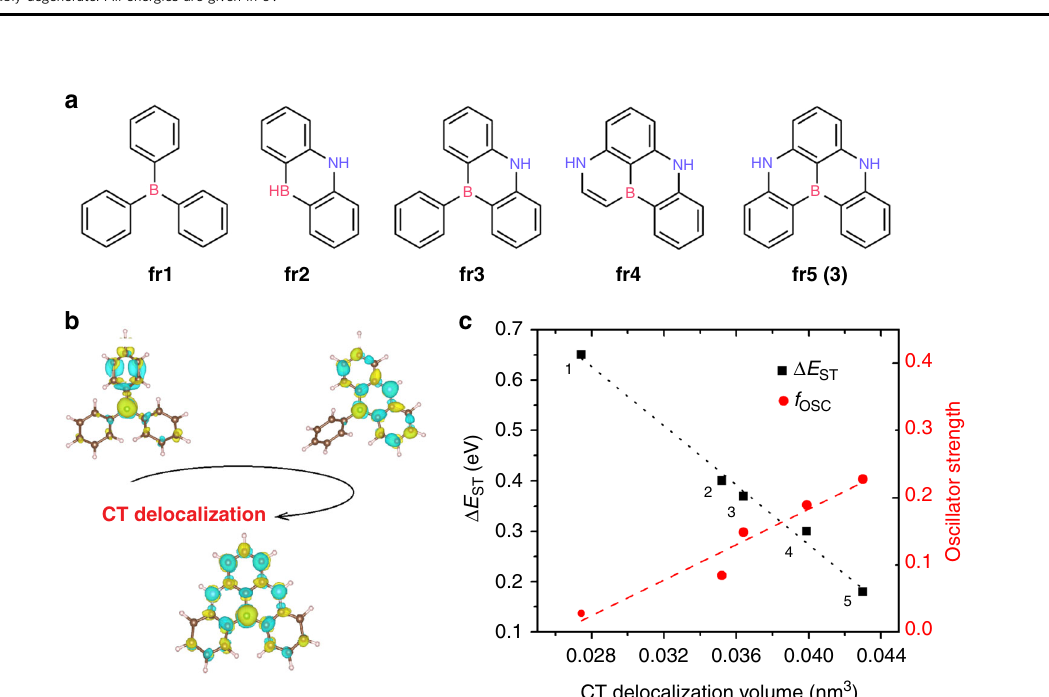
Fig. 2 Charge transfer delocalization helps in decreasing the singlet-triplet energy gap and increasing the oscillator strength. a Chemical structures of DABNA-1 fragments. b Difference density plots computed for selected fragments from a . c Δ E ST (black squares) and oscillator strengths, f osc (red dots) as a function of CT delocalization volume for the selected set of